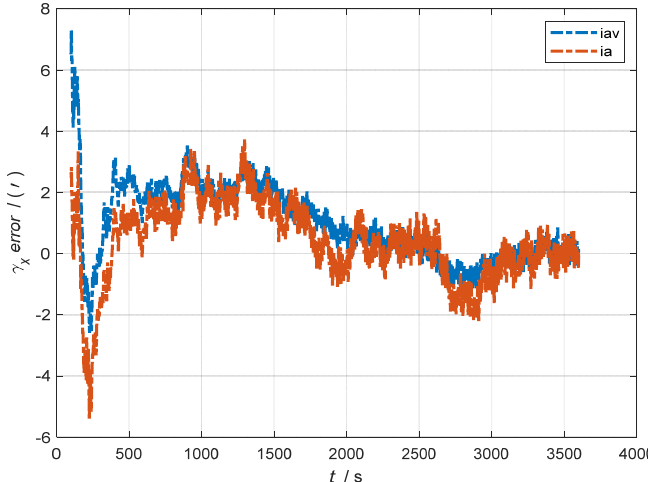
γ γ in the cases of the initial misalignment angles T [5 5 20 ] ° ° ° . Figure 22. The error curves of γ x in the cases of the initial misalignment angles [ 5 ◦ 5 ◦ 20 ◦ ] T . Figure 22. The error curves of x Figure 22. The error curves of x in the cases of the initial misalignment angles T [5 5 20 ] ° ° ° .